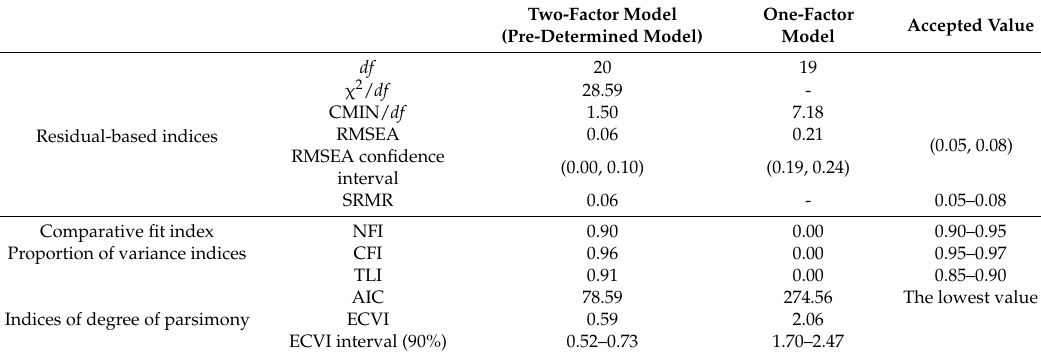
Table 5. Goodness-of-Fit Indices.